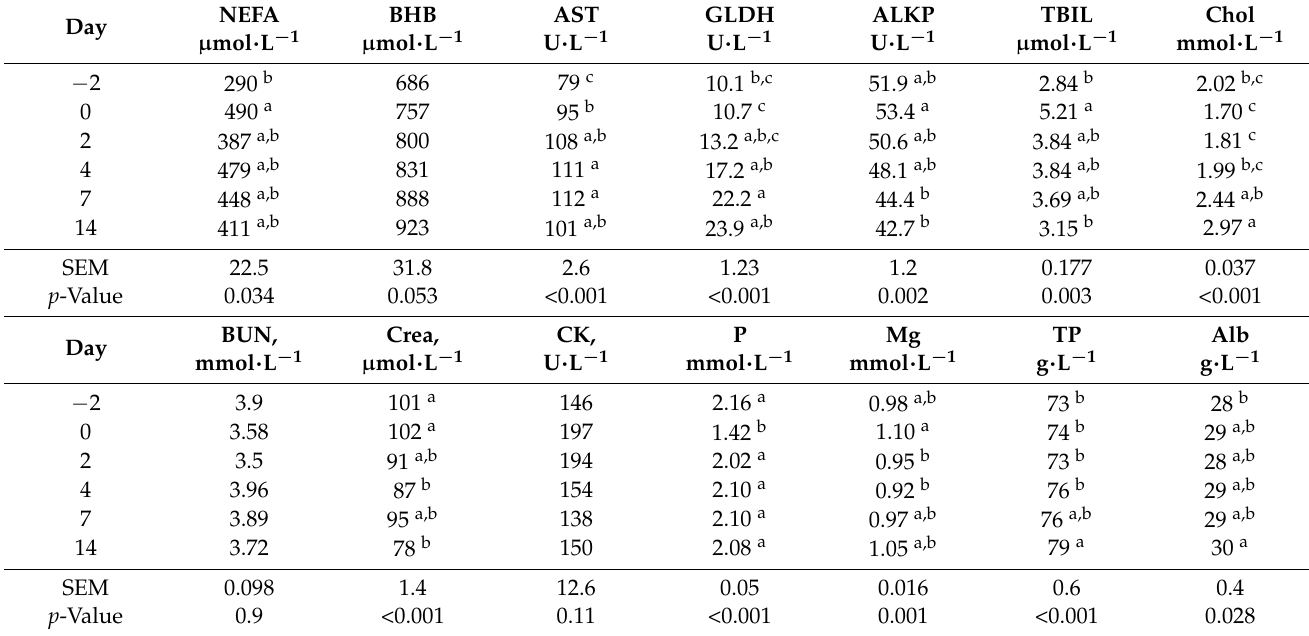
Values are means and pooled SEM. a–c values within a row with different superscripts differ significantly at p <